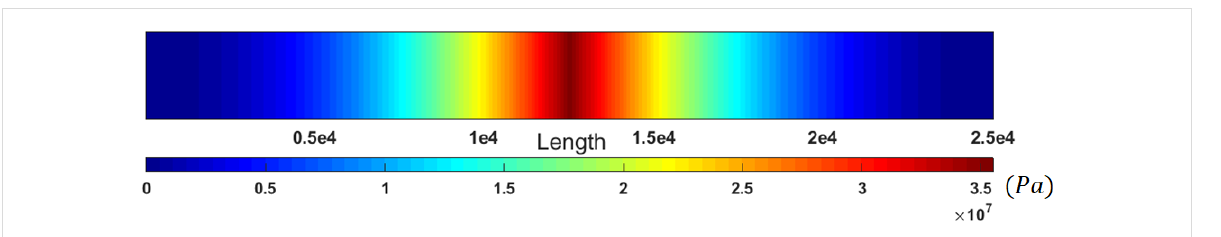
Figure 14: Classical stresses in a cylindrical gold nanoparticle with a length of 25 µm and aspect ratio of